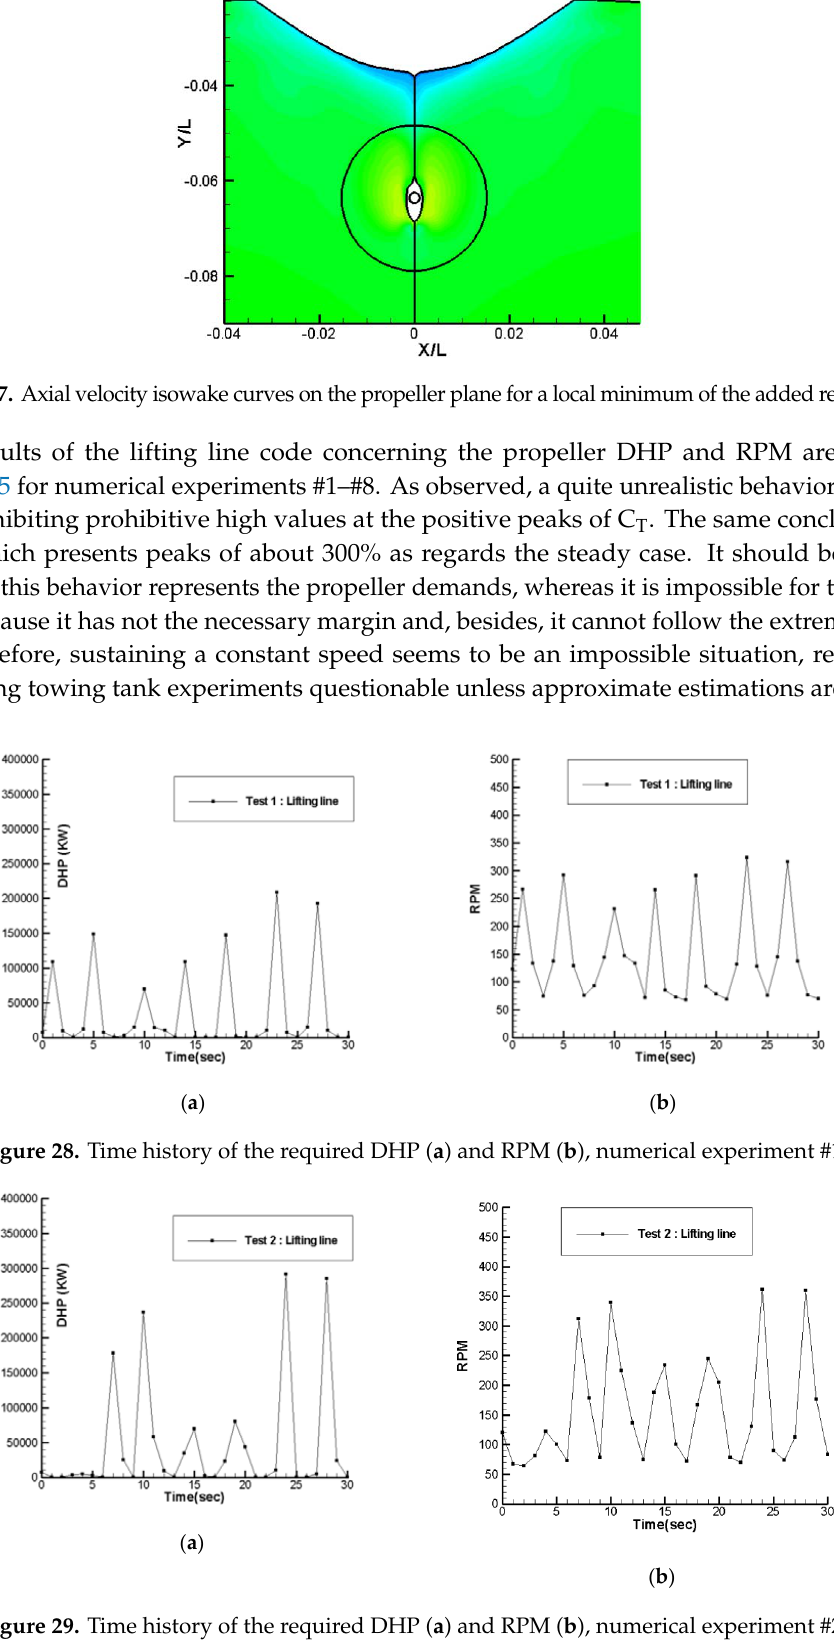
( a ) ( b ) Figure 30. Time history of the required DHP ( a ) and RPM ( b ), numerical experiment #3. ( a ) ( b ) Figure 31. Time history of the required DHP ( a ) and RPM ( b ), numerical experiment #4.